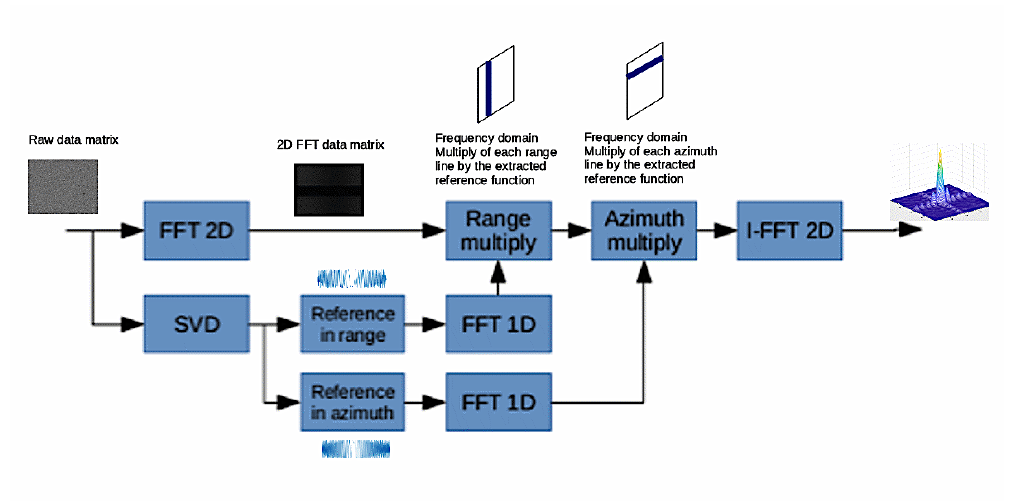
Figure 7. B-SAR Data Processing block